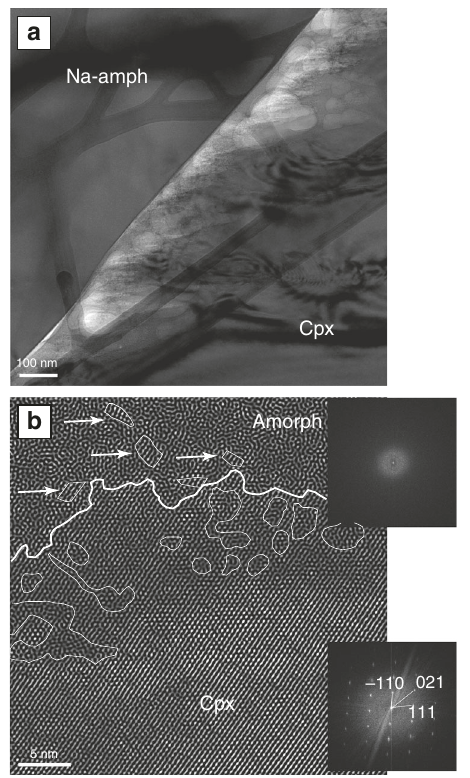
Fig. 4 Details of the reaction zone between cpx and Na-amph. a Bright- fi eld TEM image of the FIB section taken along the red line in Fig. 1c highlighting the denticulated surface of the reacting cpx. The needle-like denticles grade into an amorphous phase by a gradual de-polymerization of the cpx lattice as shown in b . b Inverse FFT HR-TEM image showing the cpx dissolution process. The cpx surface is highly lobate and within the crystal amorphous regions develop. In turn, small fragments of the original crystal can be seen in the amorphous material (arrows). The calculated diffraction patterns demonstrate the structural differences between the reacting cpx and the amorphous phase